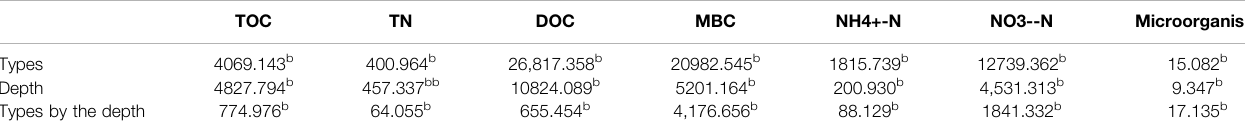
TABLE 1 | Two-factor variance analysis of soil physical and chemical properties on frozen soil type and soil depth ( F -value). TOC